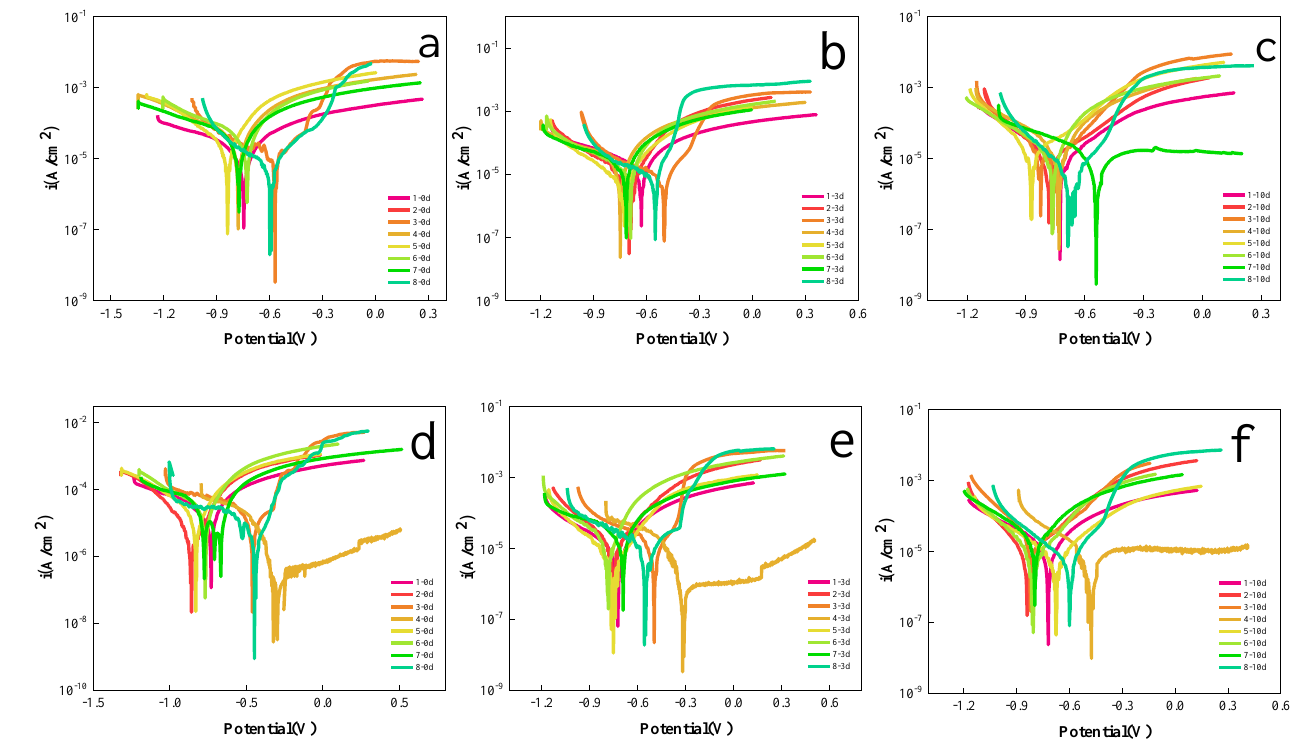
Figure 11. Dynamic potential polarization curves of two types of ductile iron during different periods of immersion in eight simulated water conditions, ( a – c ) are ductile iron without mechanical treatment; ( d – f ) are ductile iron with mechanical treatment.